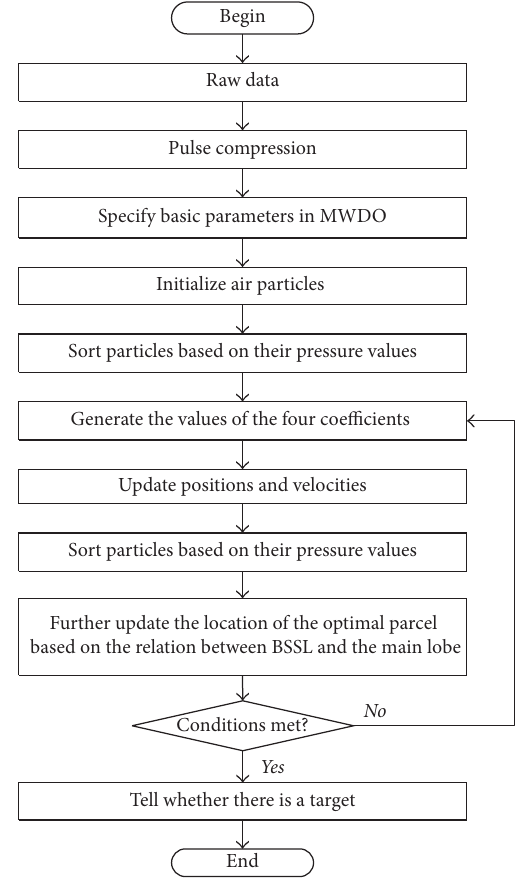
Figure 2: Flow chart of the target detection method via